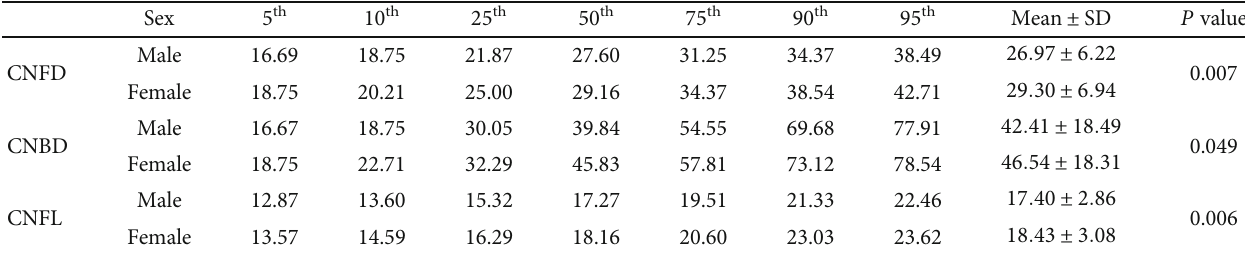
Table 3: Descriptive statistics for the distribution of corneal nerve fi ber parameters in male and female participants.